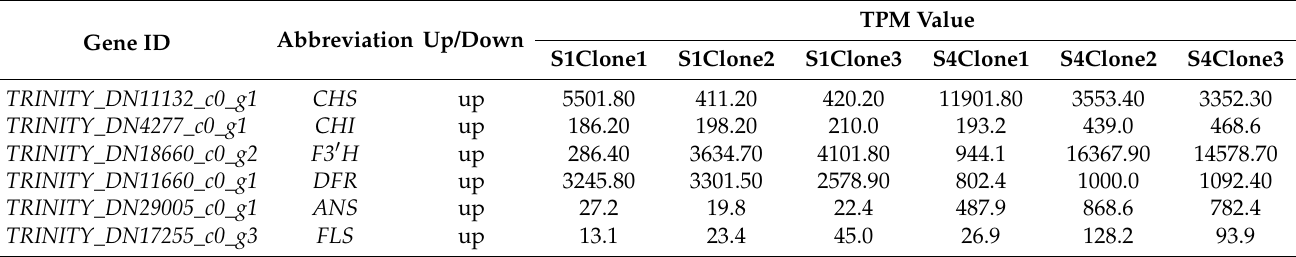
Table 1. DEGs related to anthocyanin biosynthesis in three clones.